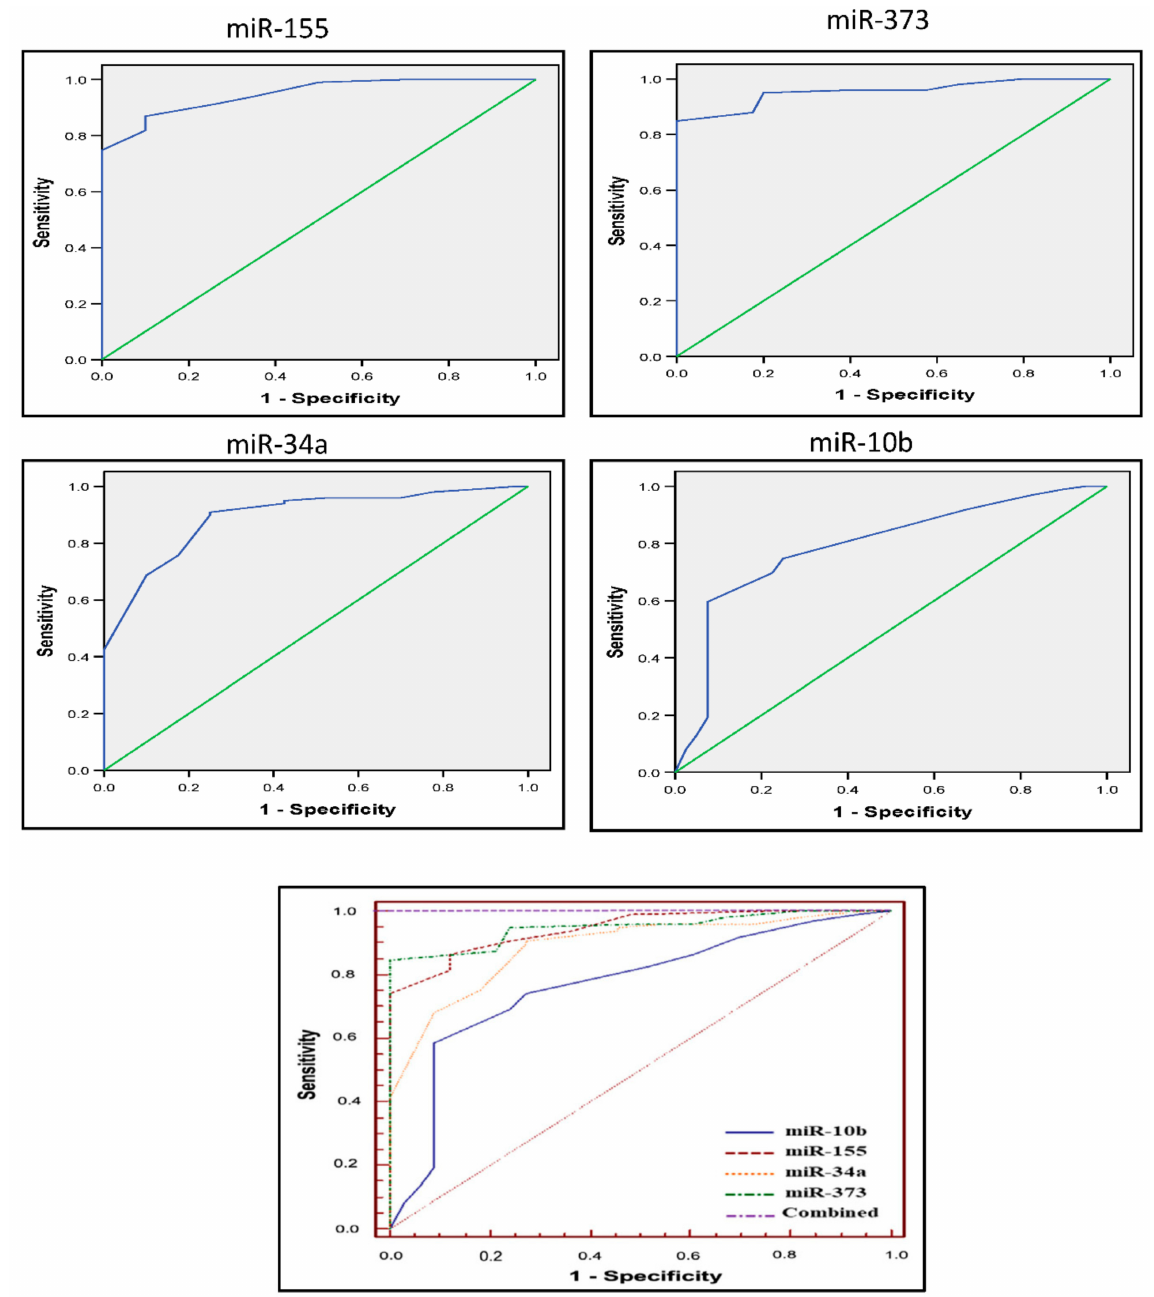
Figure 3. Sensitivity versus specificity plots for the four miRs using the ROC